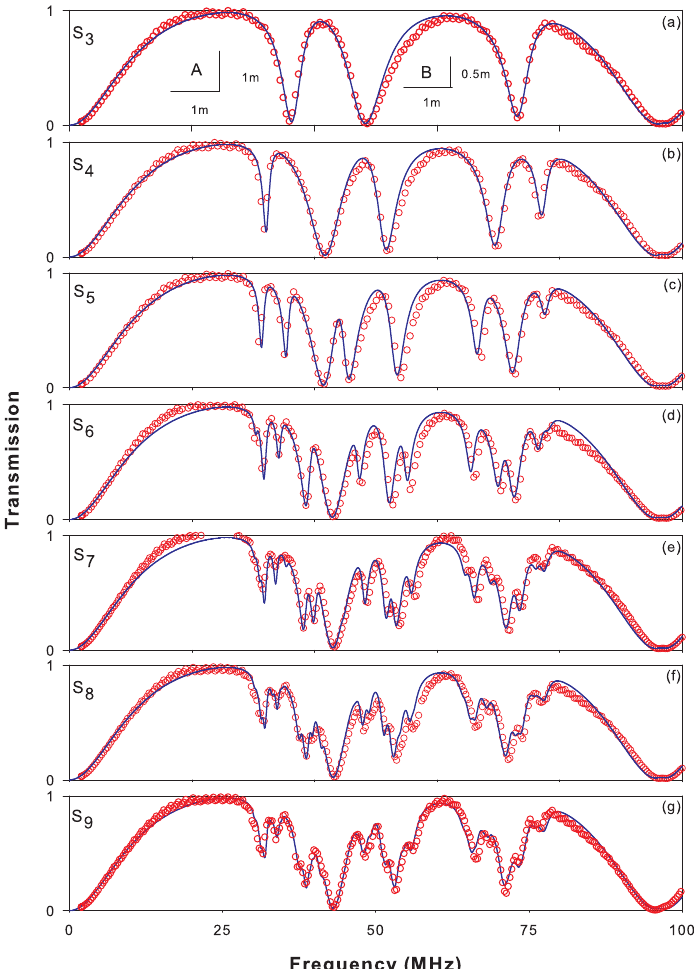
Figure 6. Theoretical (solid curves) and experimental (open circles) variations of the transmittance versus the frequency for a Fibonacci sequence inserted vertically along a waveguide (Figure 1g) for the generations S 3 – S 9